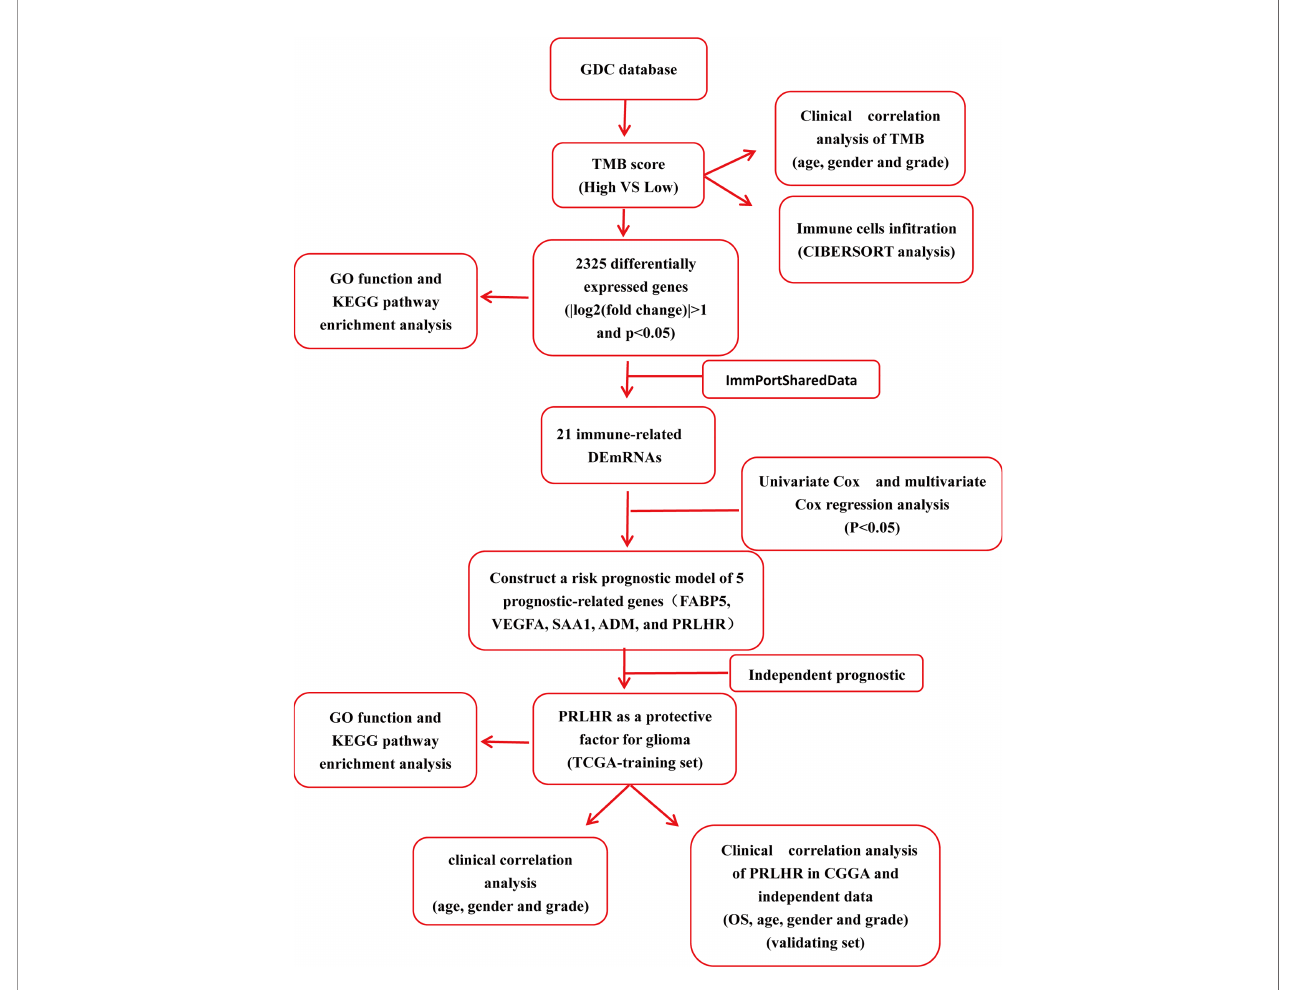
FIGURE 1 | The fl ow chart of the